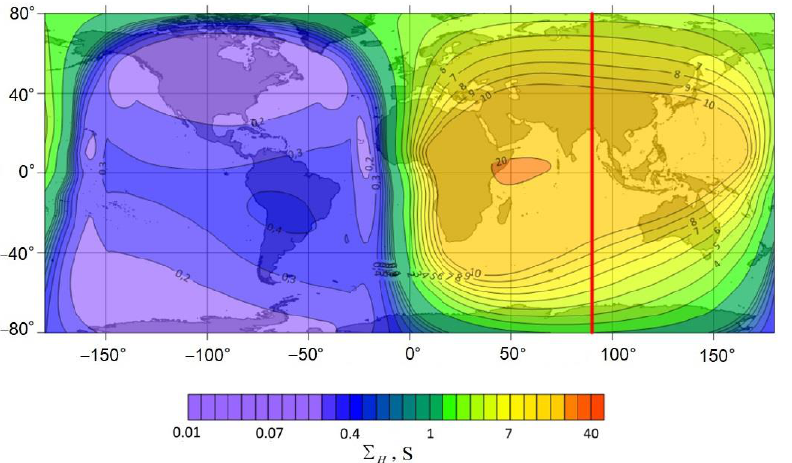
Figure 11. Hall background conductivity. The red vertical line shows the position of the subsolar meridian.